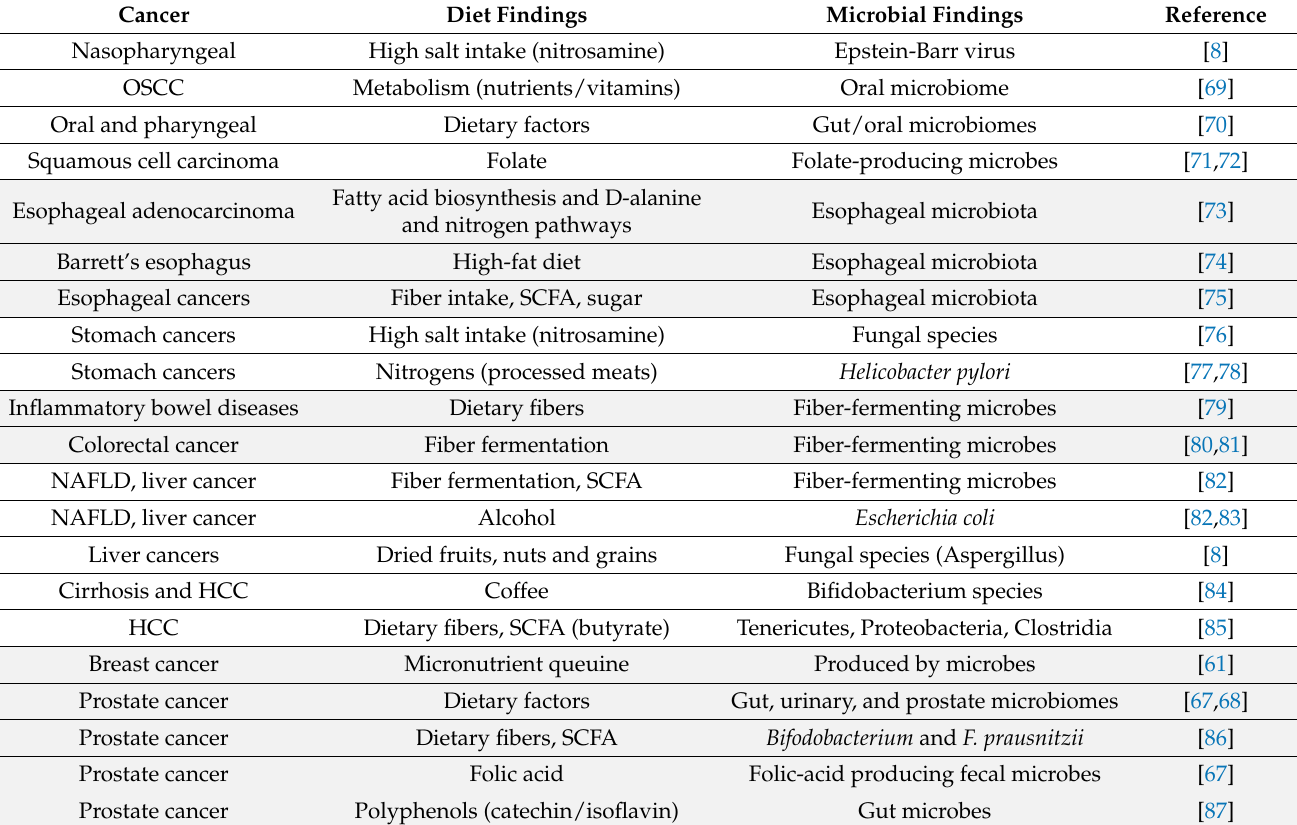
Table 1. Studies that examined diet, microbiome, and tumorigenesis in specific